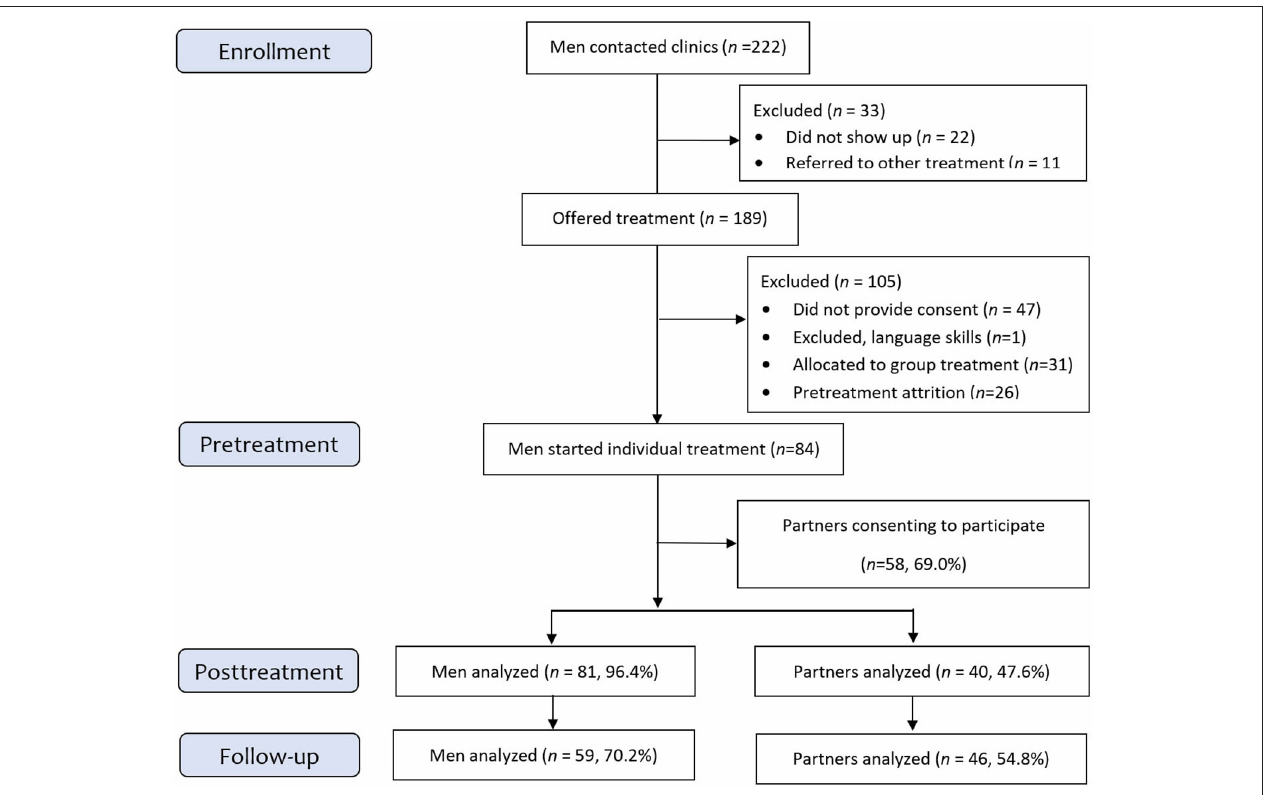
FIGURE 1 | Flowcharts of